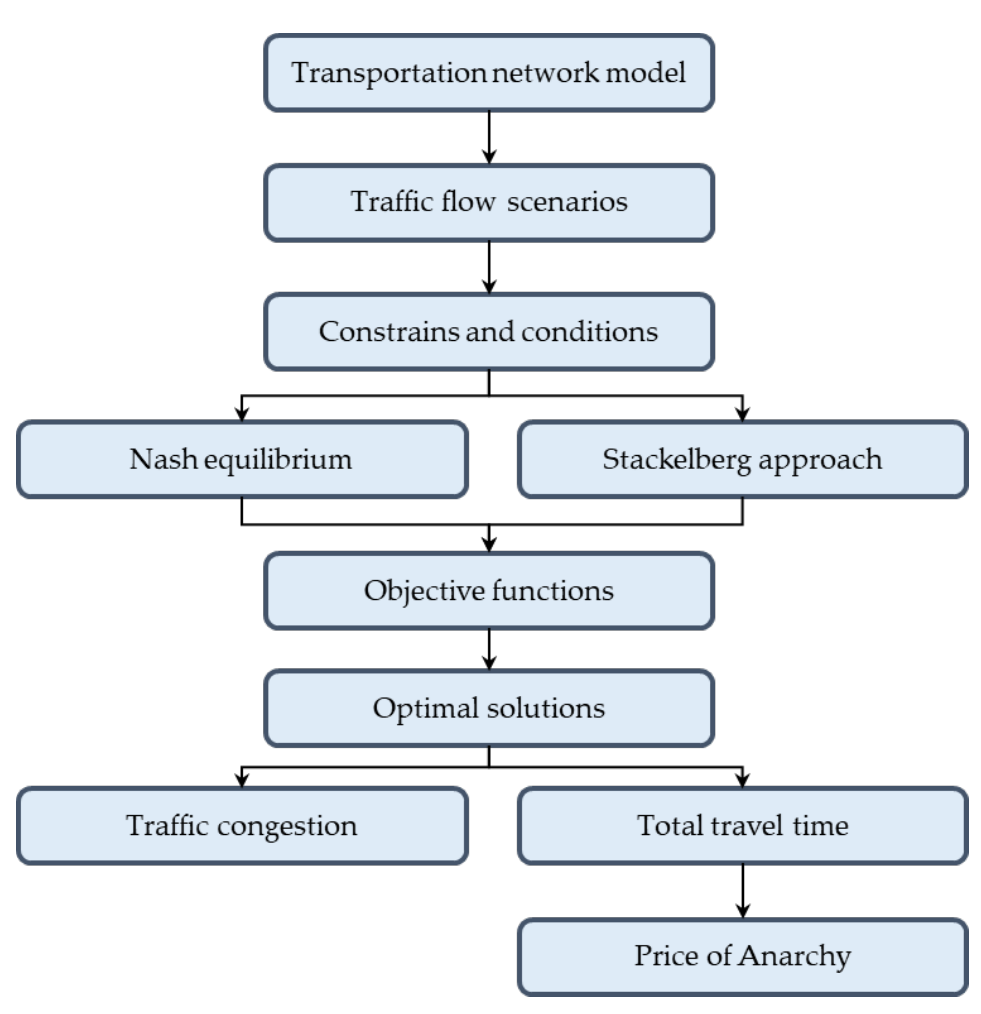
Figure 2. This is a figure. Schemes follow the same formatting. If there are multiple panels, they Figure 2. Flowchart of the should be listed as: ( a ) Description of what is contained in the first panel. ( b ) Description of what is contained in the second panel. Figures should be placed in the main text near to the first time they are cited. A caption on a single line should be centered.